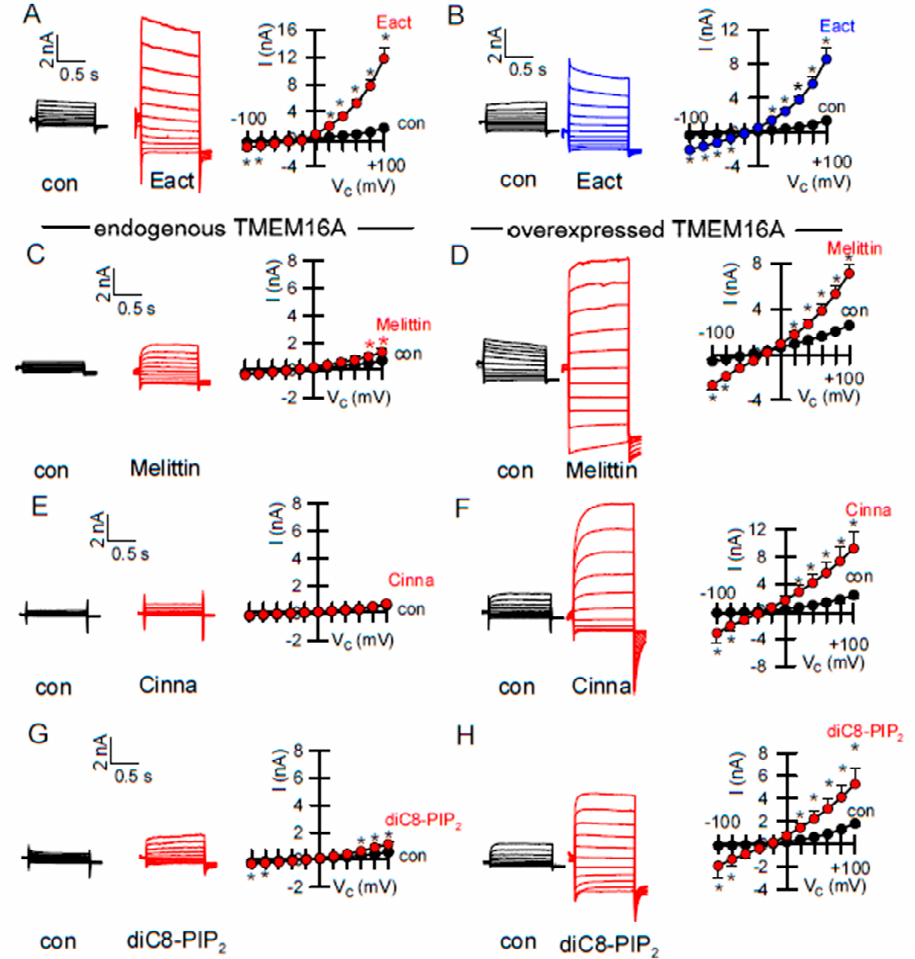
Figure 5. Endogenous and overexpressed TMEM16A behave di ff erently. ( A ) Activation of overexpressed TMEM16A whole cell currents in HEK293 cells by Eact (10 µ M, n = 9). ( B ) Activation of TMEM16F whole cell currents in TMEM16F-overexpressing HEK293 cells by Eact (10 µ M, n = 6). ( C , D ) Little activation of endogenous TMEM16A currents by melittin (200 nM; n = 10) in HT29 cells, but strong activation in HEK293 cells overexpressing TMEM16A ( n = 7). ( E , F ) Little activation of endogenous TMEM16A currents by cinnamaldehyde (Cinna; 1 µ M; n = 9), but strong activation of overexpressed TMEM16A ( n = 5). ( G , H ) Little activation of endogenous TMEM16A currents by diC8-PIP 2 (50 µ M; n = 6), but strong activation of overexpressed TMEM16A ( n = 6). * significant activation ( p < 0.05; paired t -test). # significant activation ( p < 0.05; unpaired t